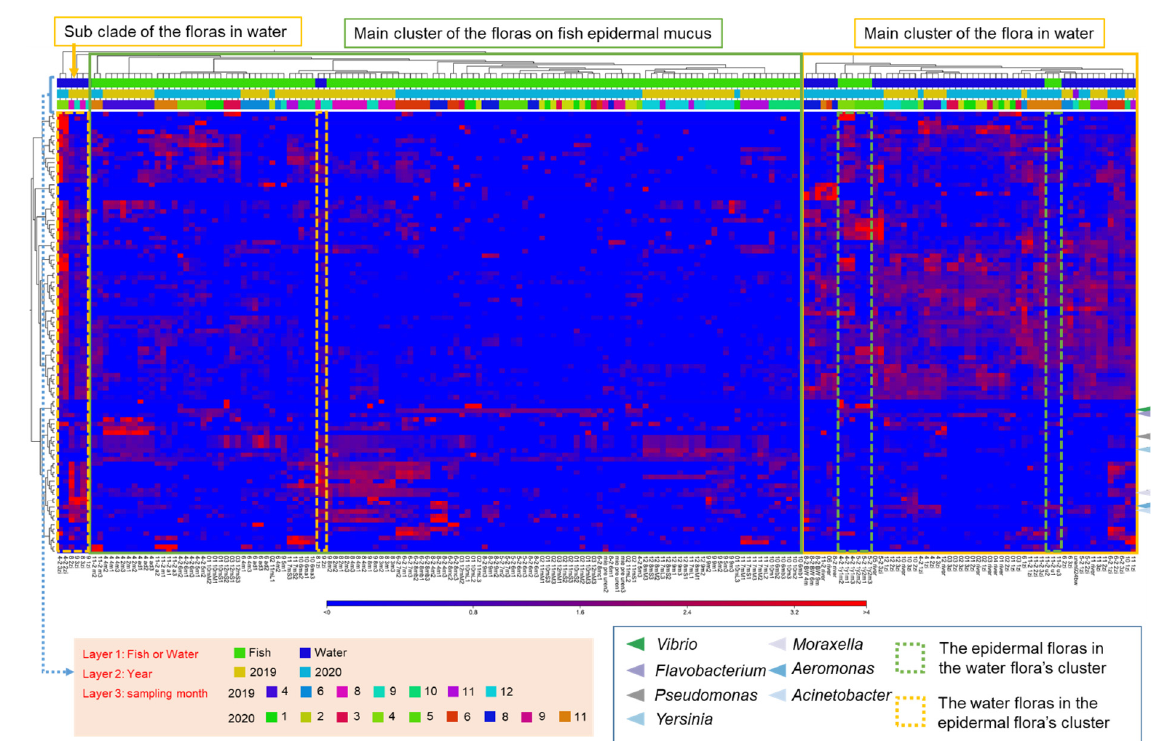
Figure 2. Specific abundance changes in OTUs obtained from fish epidermal mucus, independent of their abundance in the water or other sampling conditions. The composition of the bacterial flora from mucus samples and rearing water samples was classified based on the relative abundance of the top-100 OTUs shown in a clustered heatmap. The green frame represents the main clusters formed by the mucus samples, and the yellow frame represents the main clusters formed by the water samples. The dashed frames represent samples classified in another cluster than the main cluster. Arrowheads indicate the OTUs related to the skin-occupied bacteria. Sampling conditions (fish sample or water sample, sampling year, sampling months) are represented by bars with different colors, as defined in the